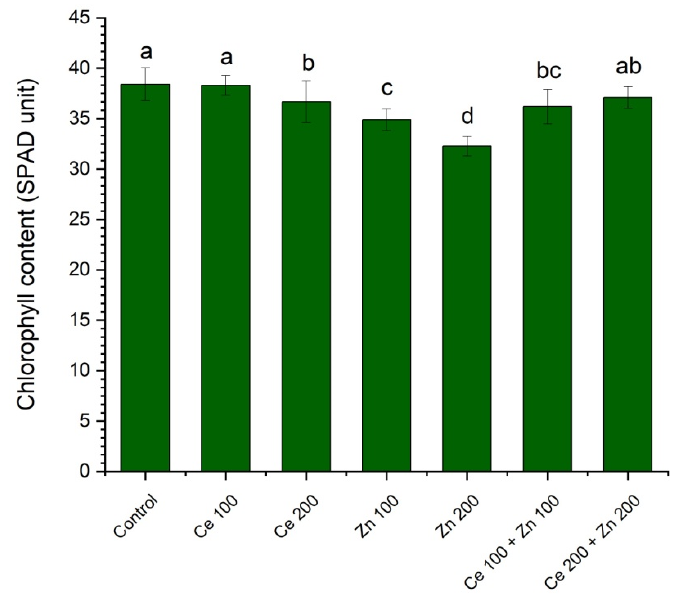
Figure 3. The influence of nanoparticulate CeO 2 and ZnO on chlorophyll content in Pisum sativum L. expressed in SPAD units. All measurements were performed on mature leaves on the 12th day from administration of the nanoparticles. Vertical bars represent standard deviations ( n = 10). Treatments with the same letter are not significantly different according to Tukey’s post hoc test ( p = 0.95).